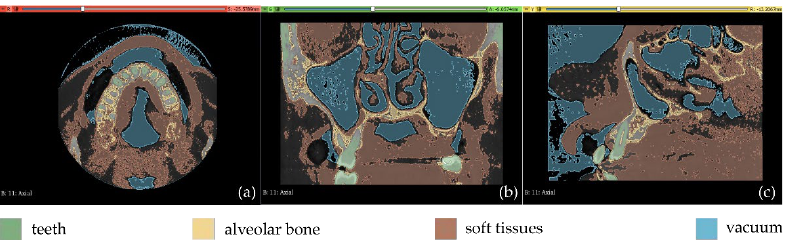
Figure 8. Automatic thresholding results (Experiment 3); ( a ): axial plane; ( b ): coronal plane; ( c ) sagittal plane.